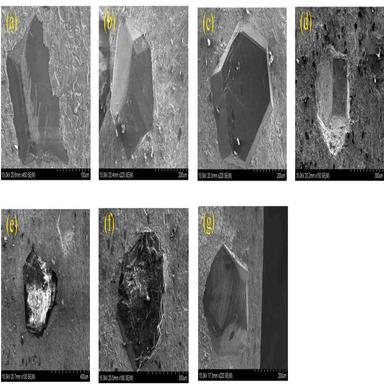
Wear classification of the DGs: (a) fresh; (b) whole; (c) micro fractured; (d) pulled-out; (e) flush with matrix; (f) macro fractured; (g) blunt.